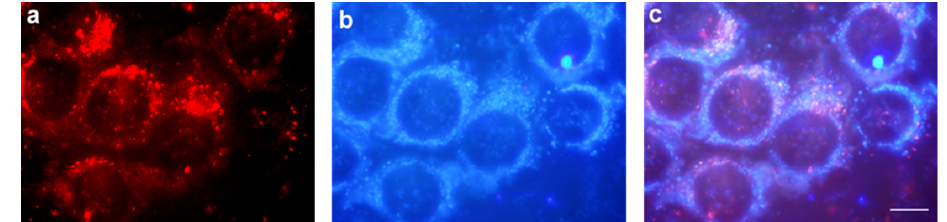
Figure 8. HeLa cells treated with 2 μ M PhA for 4 h observed in fluorescence microscopy. ( a ) Cells observed under green light excitation; ( b ) the same field observed under UV light; ( c ) overlapping images from ( a ) and ( b ). Scale bar: 10 μ M.